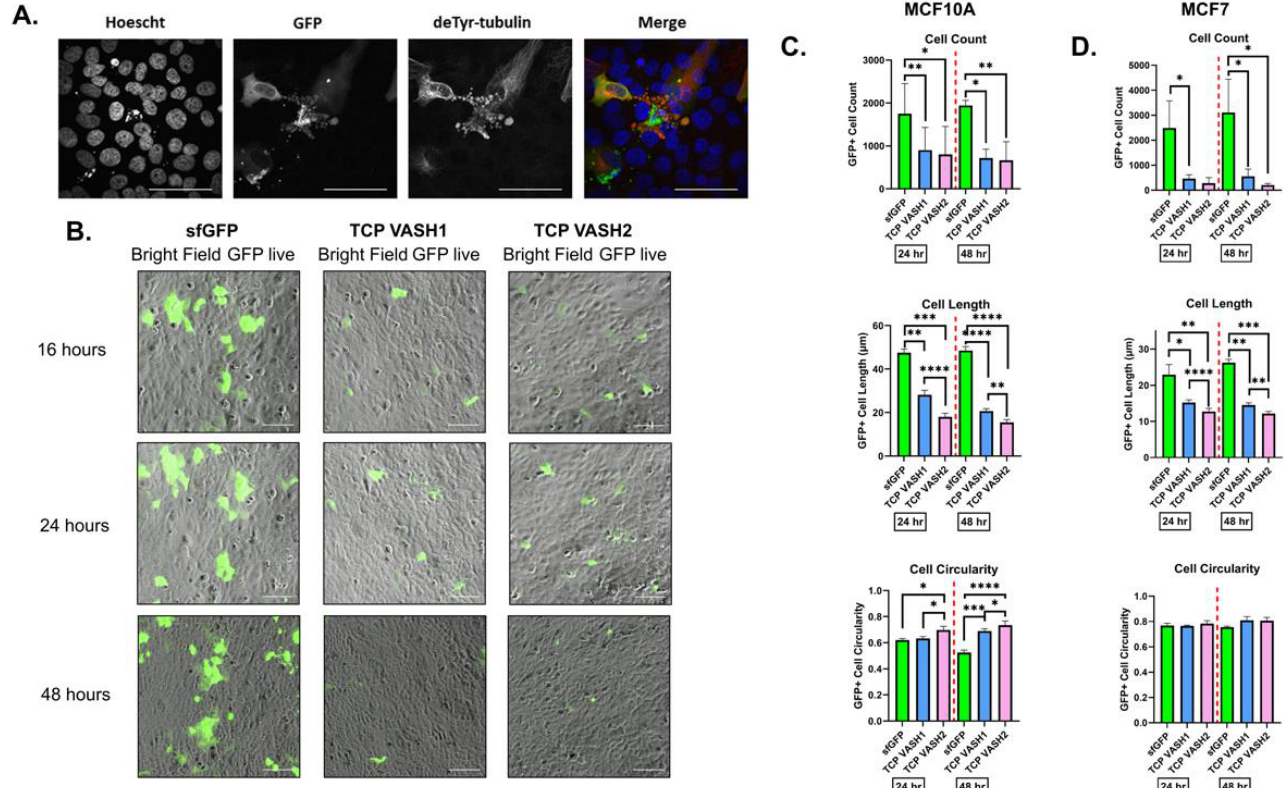
Figure 3. TCP expression induced cell death in MCF10s and MCF7s. ( A ) MCF10A cells